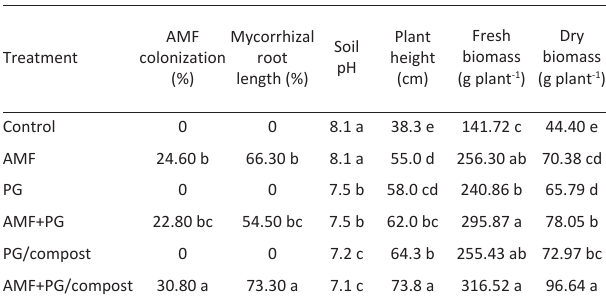
Table 1 - Experimental soil pH, mycorrhizal root colonization, and some growth parameters of cotton plants grown with different treatments of arbuscular mycorrhizal fungi (AMF) and added phosphogypsum (PG) Treatment